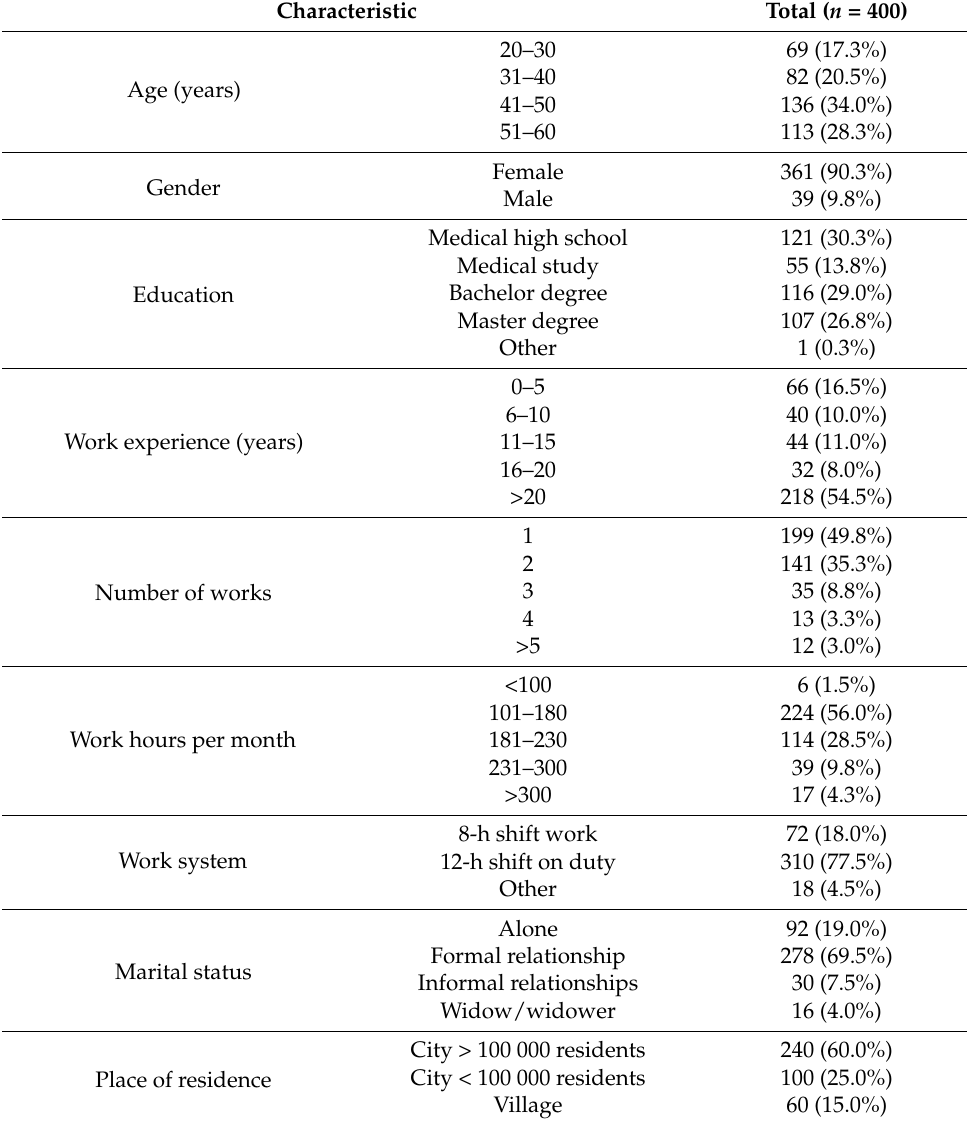
Table 1. Sociodemographic and work-related characteristics of the nurses ( n =